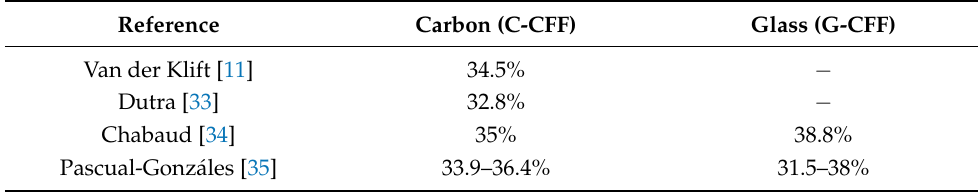
Table 2. Fiber volume contents of fiber filaments given in the literature.